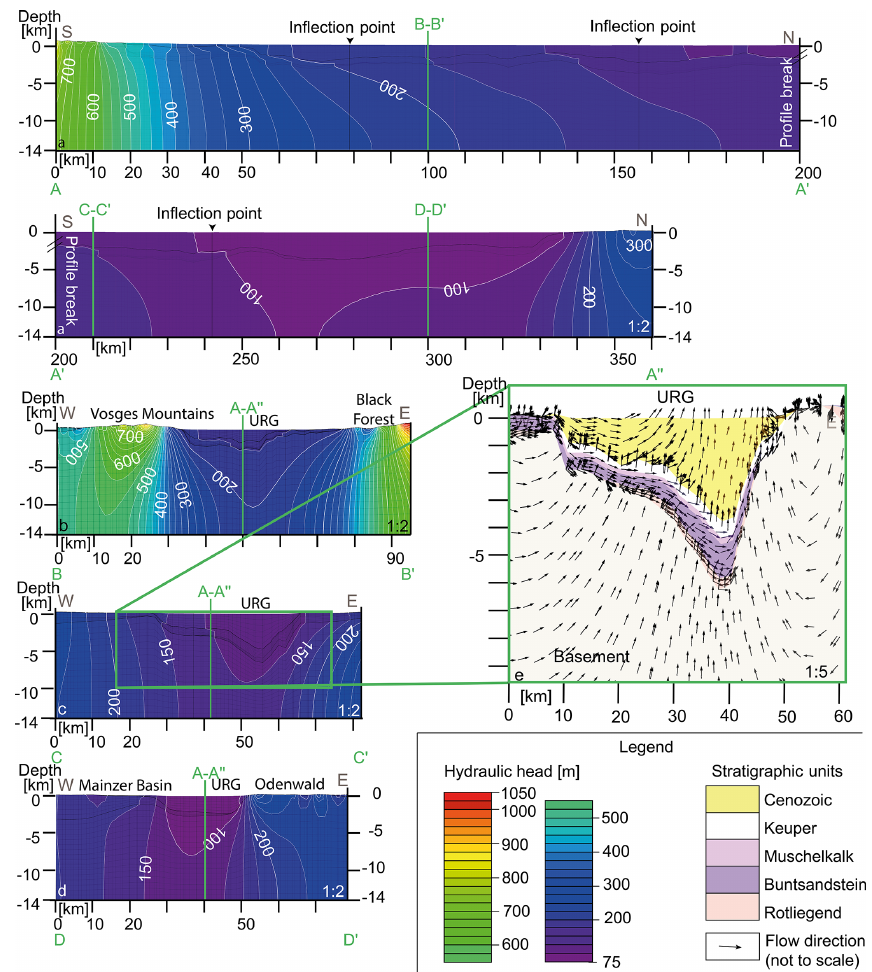
Figure 4. Simulated hydraulic head distribution (a–d) . Colors from purple to red and white isolines show hydraulic head variations in 25m fringes. Profiles cross-cutting the URG axis (a) along the URG from south to north, with a profile break after 200km, and perpendicular to the graben (b) in the south from the Vosges Mountains to the Black Forest; (c) in the central part of the URG and (d) in the northern part from the Mainzer Basin to the Odenwald. The locations where profiles intersect are marked with vertical green lines. All profiles are 2 times vertically exaggerated. Figure (e) illustrates a zoom of the profile in panel (c) with 5 times vertical exaggeration; the colors represent geological units, and the non-scaled black arrows represent flow directions. All profile locations are shown in Fig.